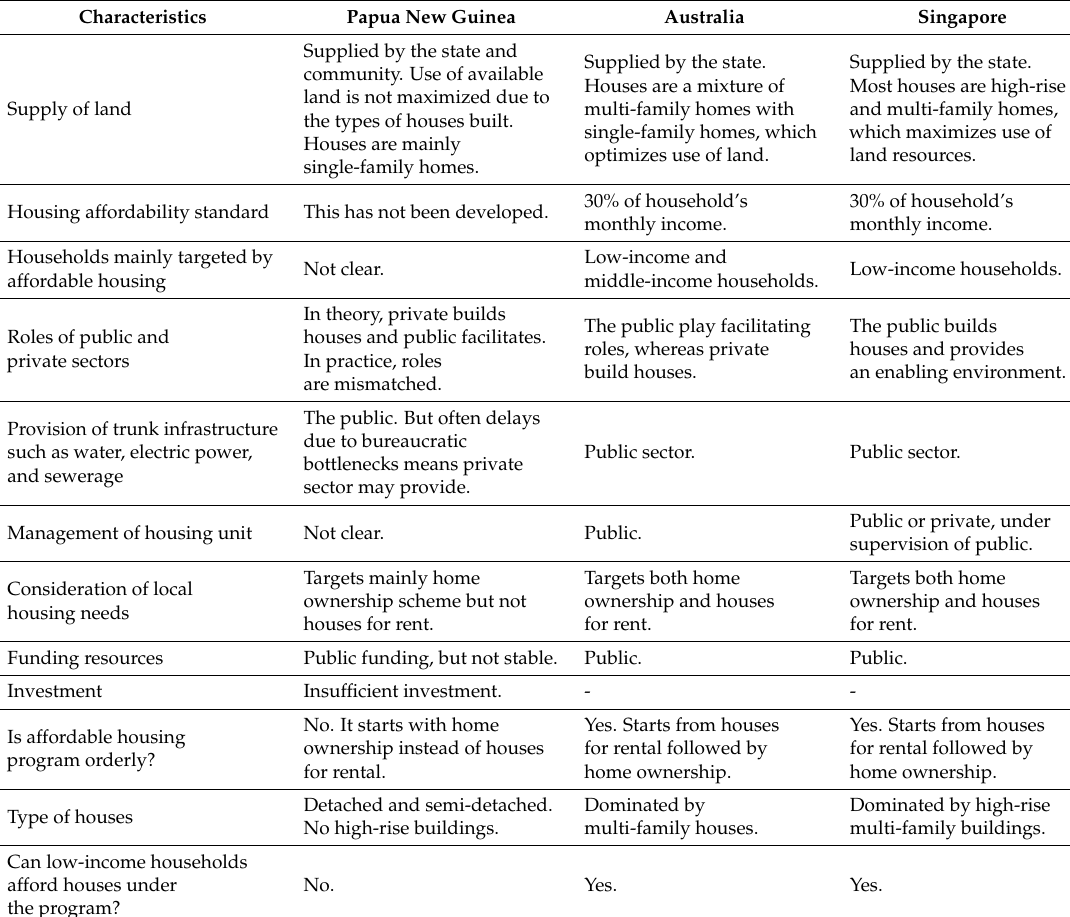
Table 1. Provision of affordable housing in Papua New Guinea, Australia, and Singapore.